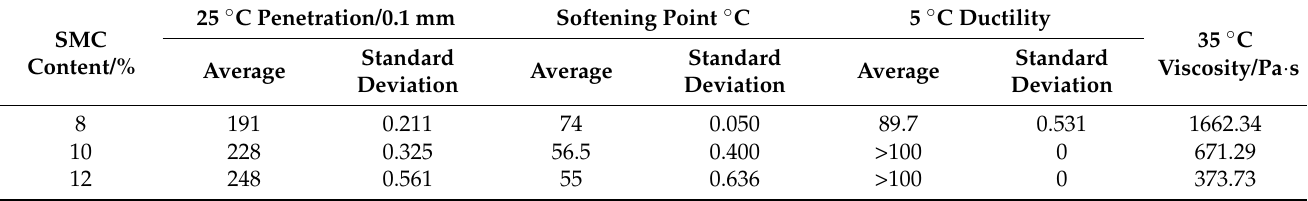
Table 4. Studies the process indexes of modified asphalt with different content.